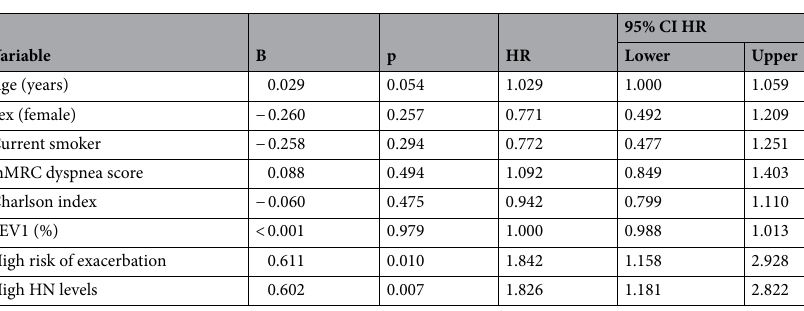
Table 5. Multivariate Cox proportional risk analysis showing predictors of moderate COPD exacerbations (dependent variable). High humanin levels = humanin higher than the median (> 246 pg/mL). High risk